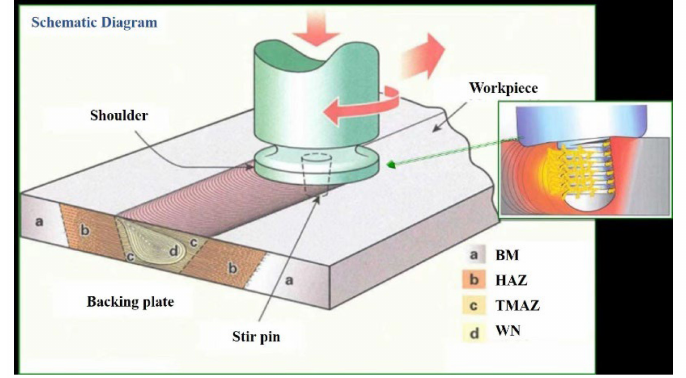
Figure 2. Schematic diagram of welding